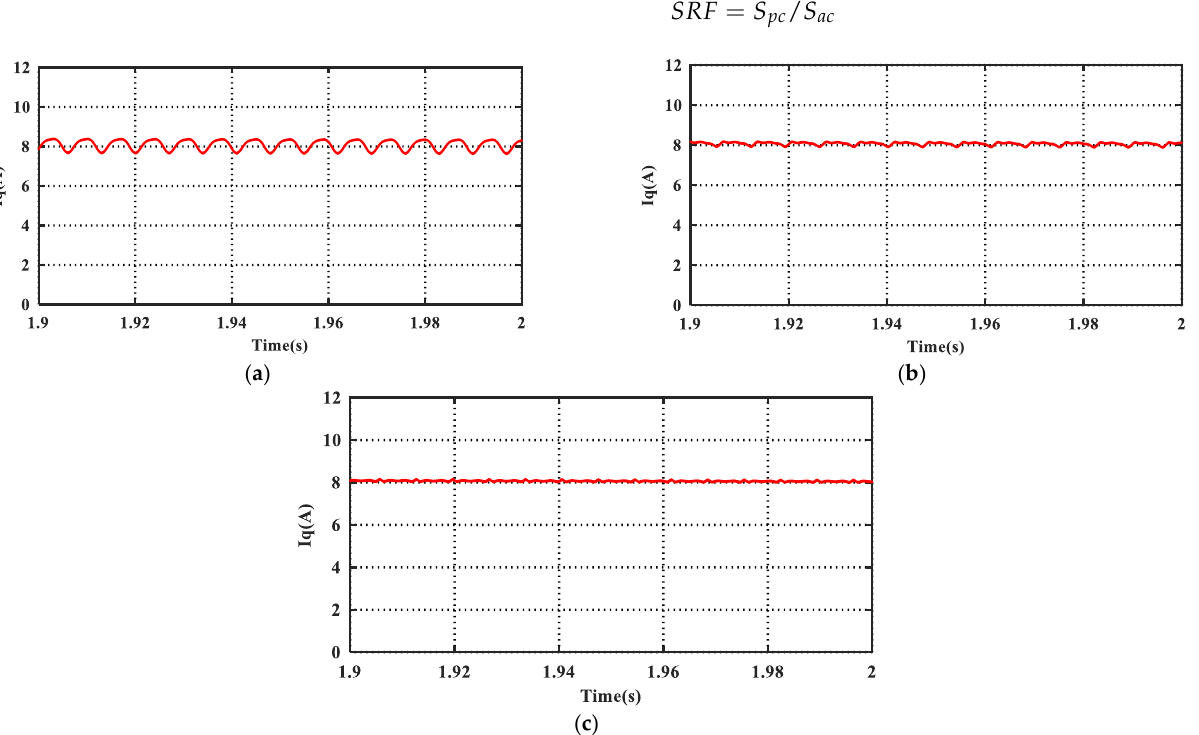
Figure 11. Simulation results of the q -axis current in the steady-state without load: ( a ) with a PI controller, ( b ) with a PIR controller and ( c ) with a Robust-TDOFR controller.